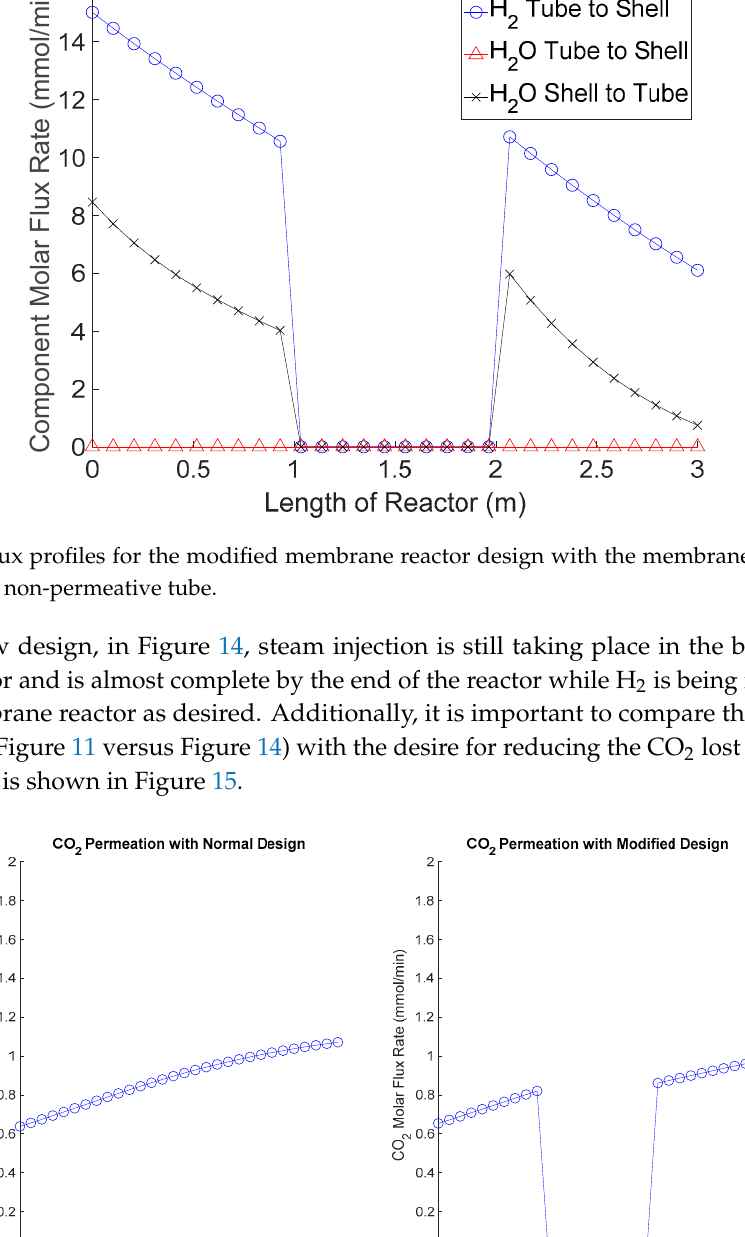
the reactor. ( b ) Flux profile for the modified design where the polymer membrane was replaced with